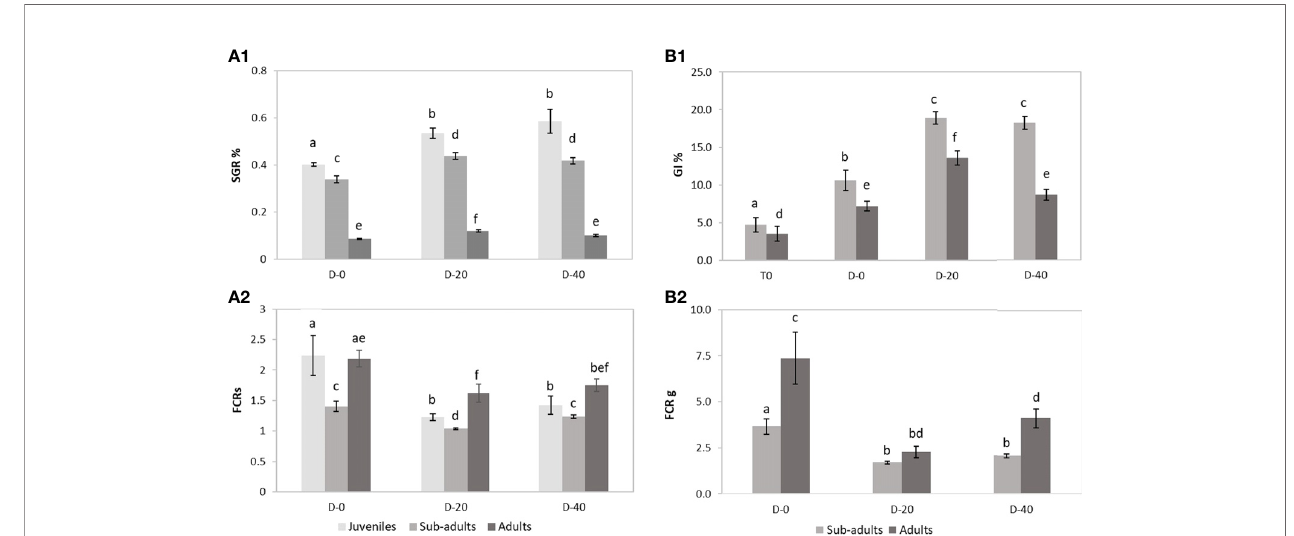
FIGURE 2 | Somatic and gonadal growth performances in a four-month experiment across three P. lividus life stages (juveniles, sub-adults and adults) fed with three different diets (D-0, D-20 and D-40) (n=12 sea urchins for each condition). (A1) Somatic growth rate (SGR); (A2) Feed conversion ratio in somatic weight (FCRs), based in dry weight; (B1) Gonad index (GI%); (B2) Feed conversion ratio in gonads (FCRg), based in dry weight. Error bars indicate standard errors of the means. Columns with the same letter are not signi fi cantly different (p>